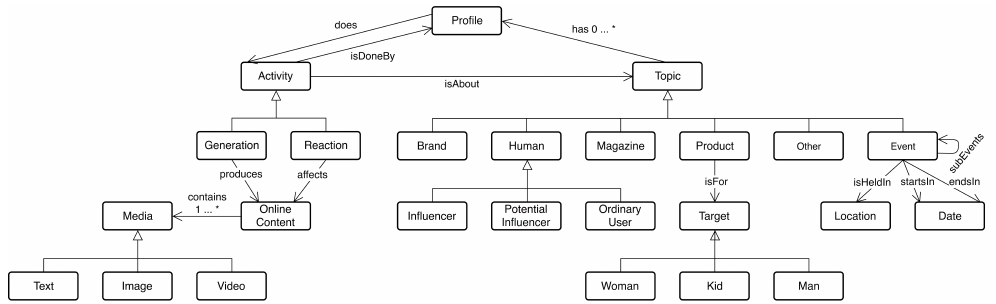
Figure 2. High-level overview of the case study’s main entities and their associations. Extended from